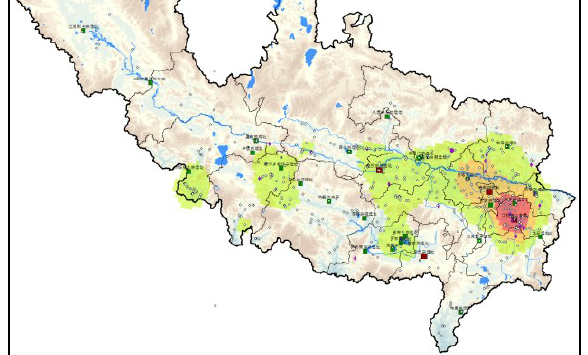
Figure 1. GIS analysis of the distribution density of districts, temples and estates in Shigatse region